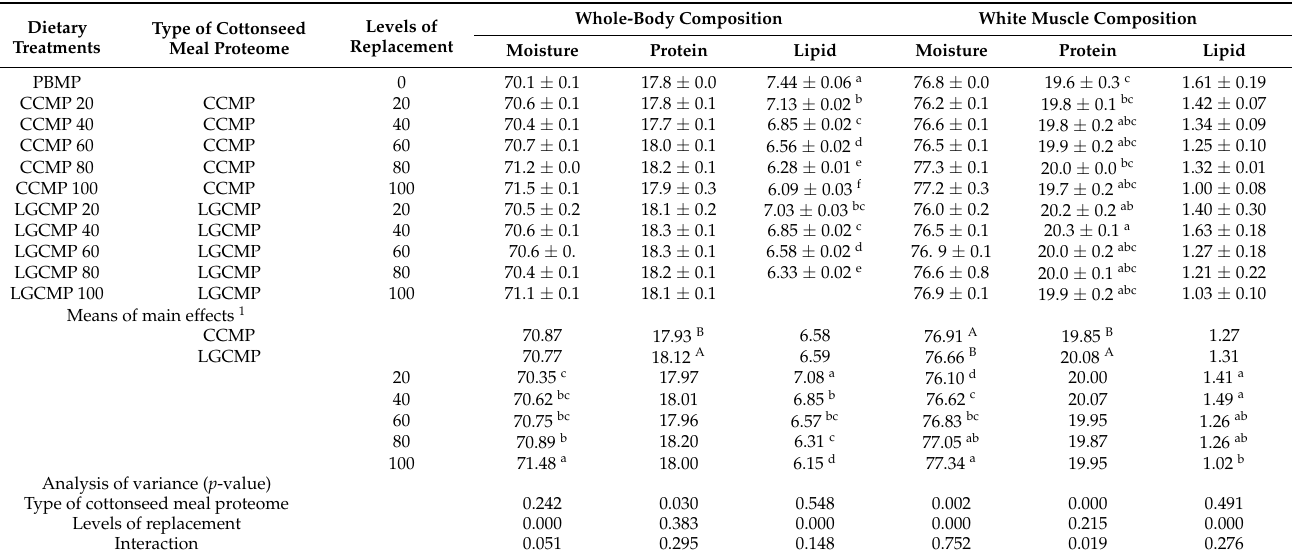
Table 5. Whole-body and white muscle compositions of hybrid grouper juveniles fed different experimental diets for 9